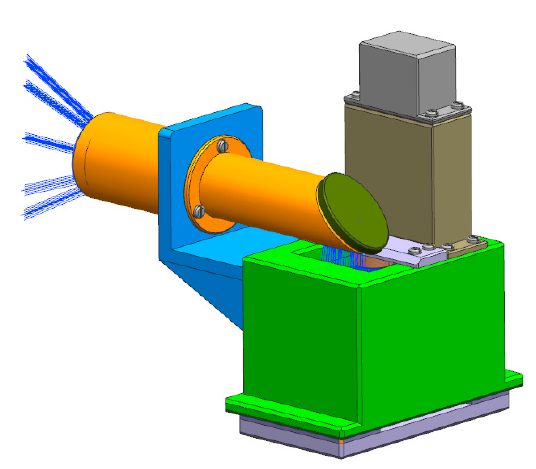
Figure 14. Integrated layout of the spectrometer.